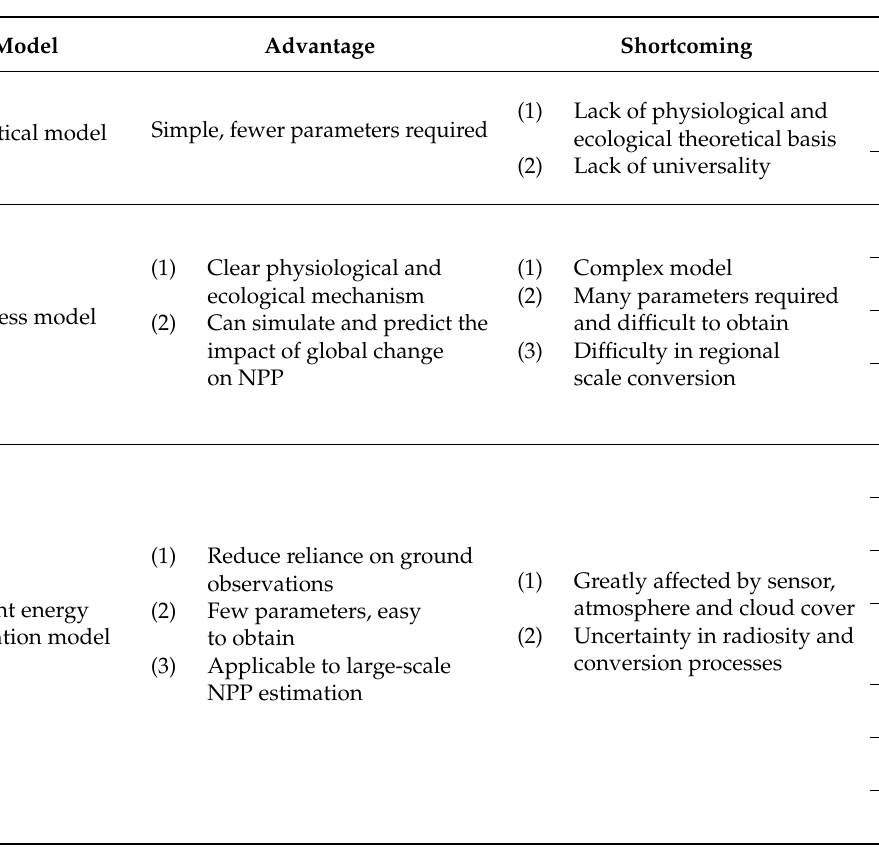
Table 4. Comparison and application of the main remote sensing